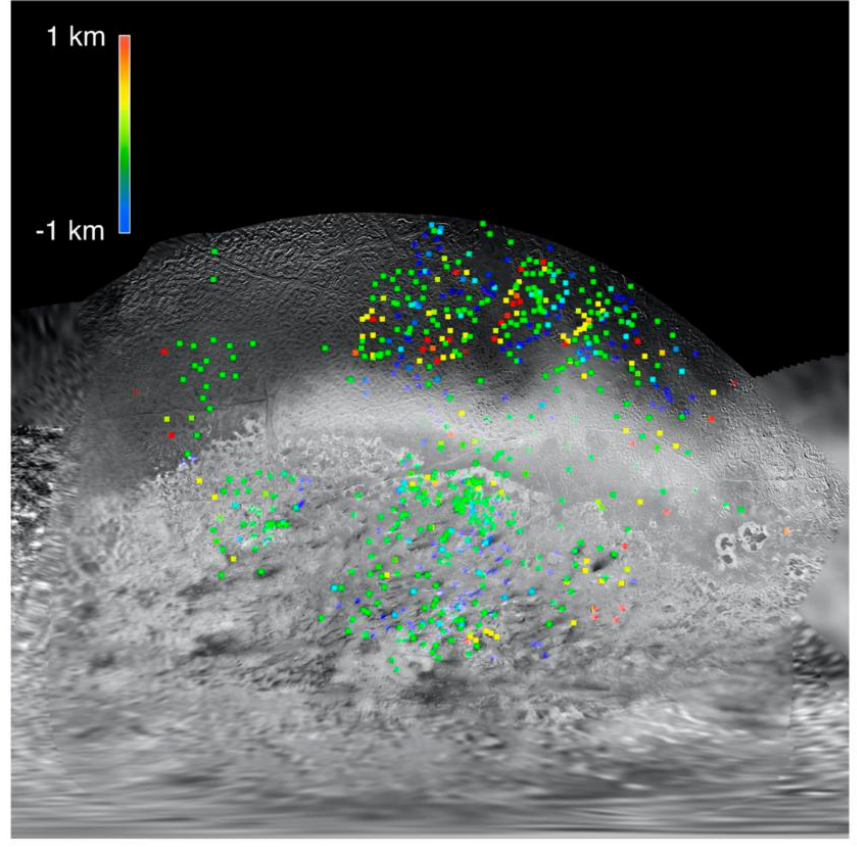
Figure 23. Multi-image match point radii (color spots) superposed on a global map of Triton. The area shown is from − 90 to 90 ◦ E